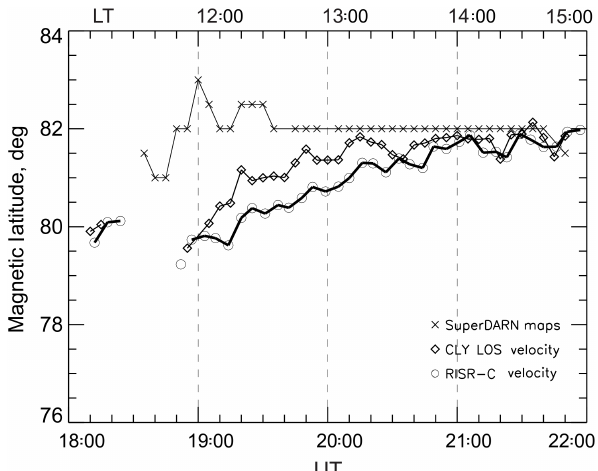
Figure 7. Magnetic latitude of the flow reversal location within the dayside reverse convection cell as inferred from SuperDARN con- vection maps (crosses), CLY LOS velocity maps (diamonds), and RISR measurements for the event of 4 March 2016. For the area of observations, local time (scale at the top) roughly coincides with the magnetic local